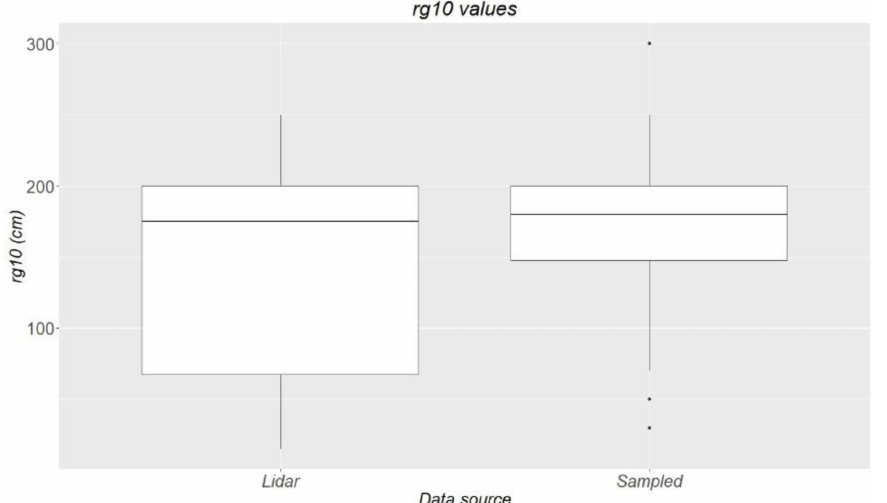
Figure 5. Comparison among roughness values ( rg10 ) extracted by LiDAR and sampled in the field. The boxplot reports the results of the values obtained through the two methodologies.